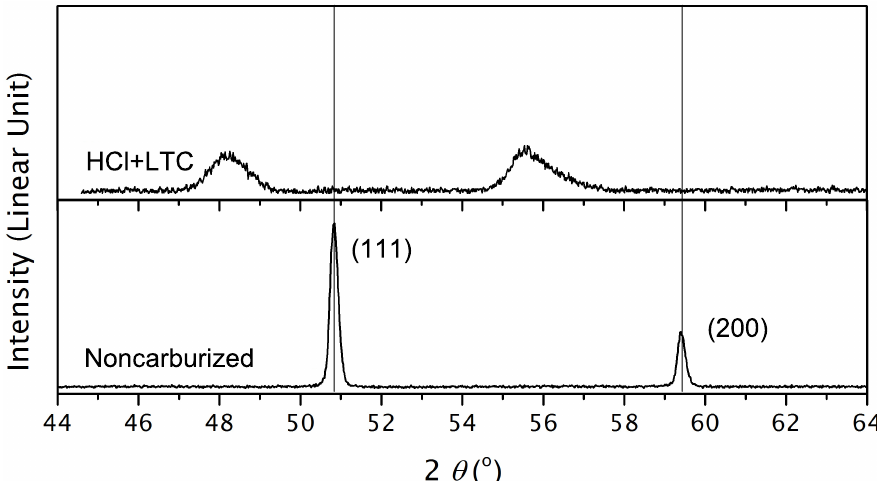
Figure 3. X-ray diffractogram of noncarburized and carburized